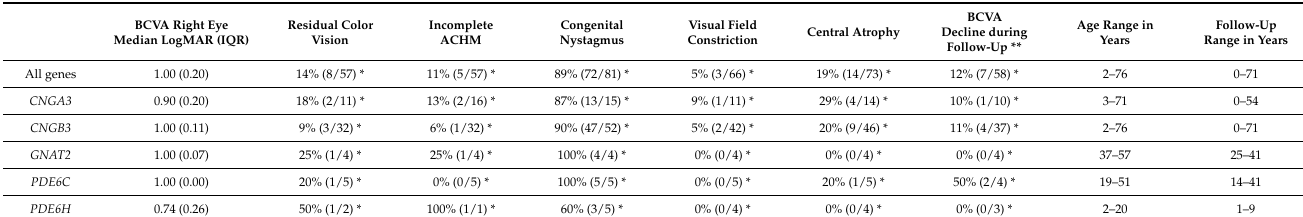
Table 1. Summary of clinical findings in all ACHM patients and in patients distributed according to specific causal